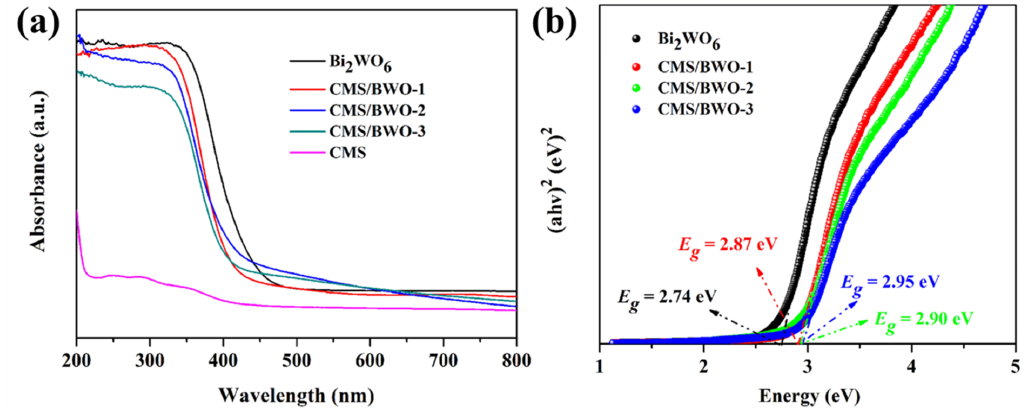
Figure 4. ( a ) UV‒Vis diffuse reflection spectra (DRS) of Bi 2 WO 6 , CMS, calcined mussel shell